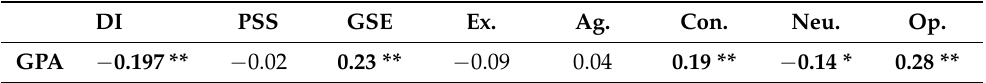
Table 2. Pearson’s Correlation coefficients between psychological attributes and mental health status and academic performances. ∗ p < 0.05, ∗∗ p <